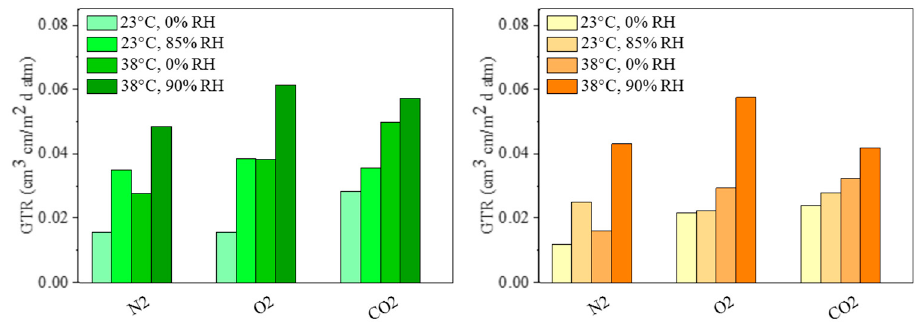
Figure 8. GTR at 23 °C and 38 °C 0% RH, at 23 °C and 85% RH, at 38 °C and 90% RH.